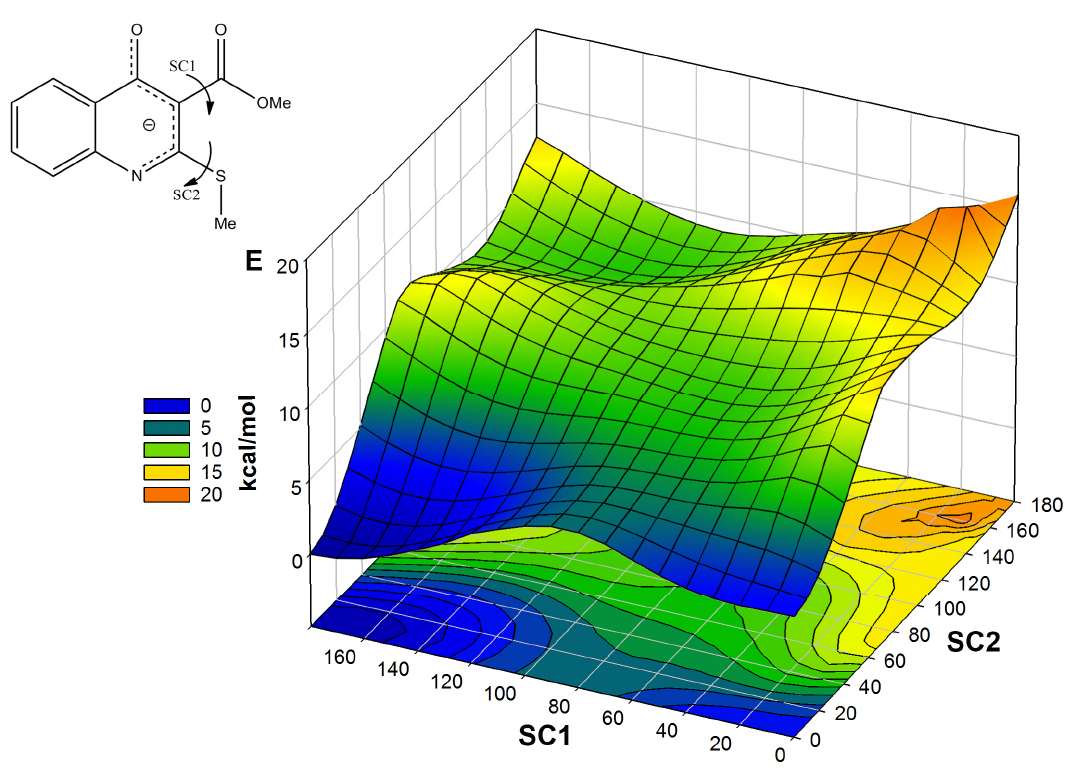
Figure 3. The Csp2–Csp2–Csp2=O and N–Csp2–S–Csp3 torsion angles used for SC1 and SC2 scanning during the study of potential energy surface (PES) in conformational analysis of 3-(methoxycarbonyl)-2-(methylthio)-1,2-dihydroquinolin-4-olate anion; PES as a function of energy and two scanned torsion angles SC1 and SC2.